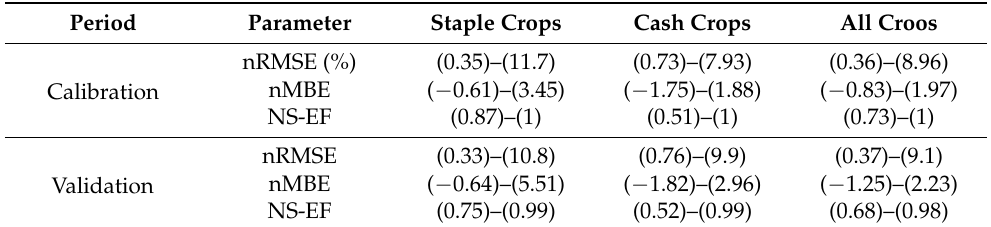
Table 5. Average of evaluation criteria including normalized root mean square error (nRMSE),